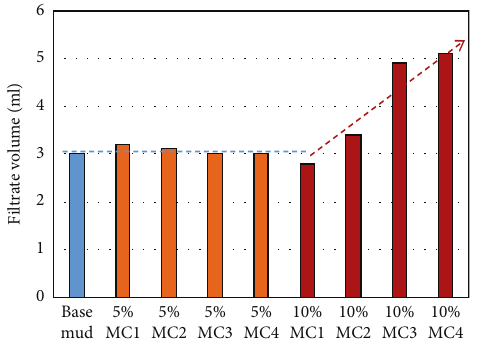
Figure 11: Filtrate volume as function of adding di ff erent cuttings to the base mud.